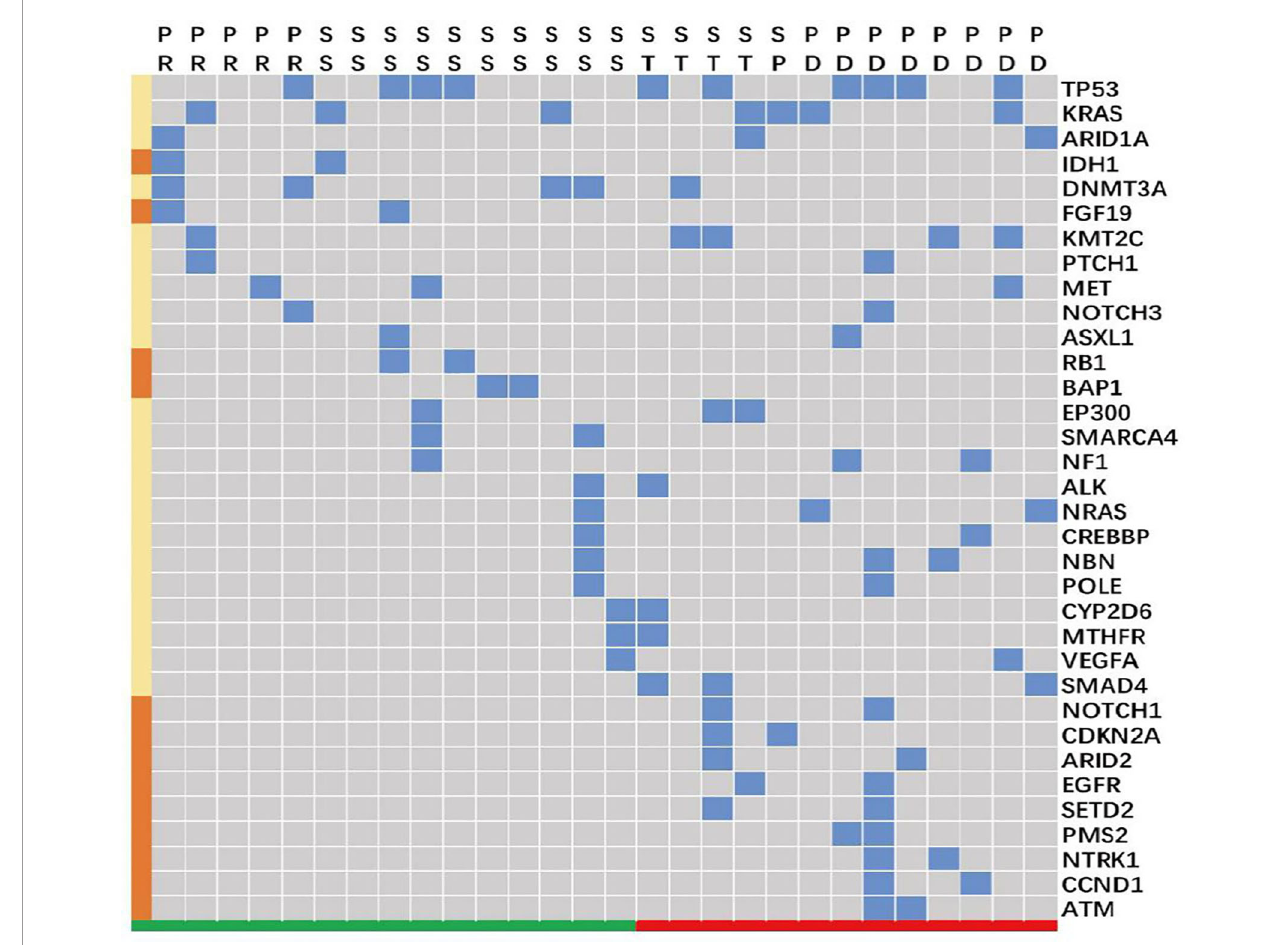
FIGURE 4 | Gene alterations in patients with biliary tract carcinoma (n = 28). SS and PR (colored in green along the bottom) clustered as a group characterized by tumor size reduction in response to treatment. ST, SP, and PD (colored in red) clustered as a ‘ non-response ’ group, which included patients who did not respond to treatment with tumor size reduction. The blue blocks represent the presence of an alteration in the indicated gene across individual patients, and the brown blocks along the left indicate that the gene alteration was present only either in the tumor size reduction group ( IDH1 , FGF19 , RB1 , and BAP1 ) or in the “ unshrinking ” group ( NOTCH1 , CDKN2A , ARID2 , EGFR, SETD2 , PMS2 , NTRK1 , CCND1 , and ATM ). PD, progressive disease; PR, partial response; SS, diminished tumor size that did not reach the partial response standard; ST, a stable disease without any signi fi cant tumor size